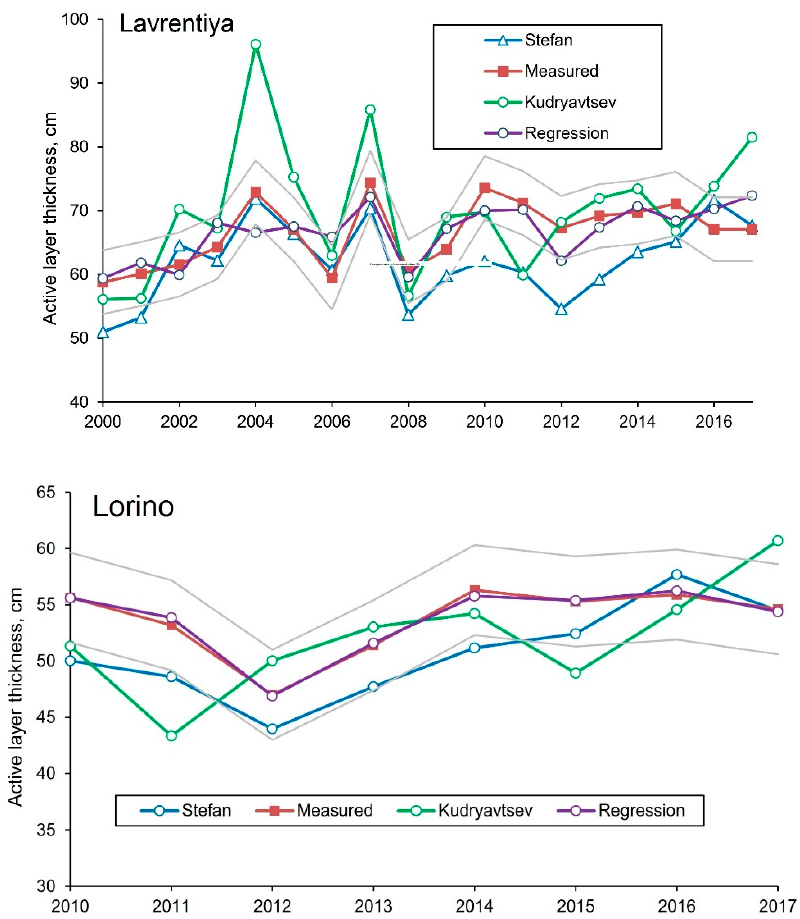
Figure 7. Comparison of measured ALT with the ones modeled with regression, Stefan and Kudryavtsev methods for the Lavrentiya and Lorino sites. Grey lines confine the standard deviations for measured values.